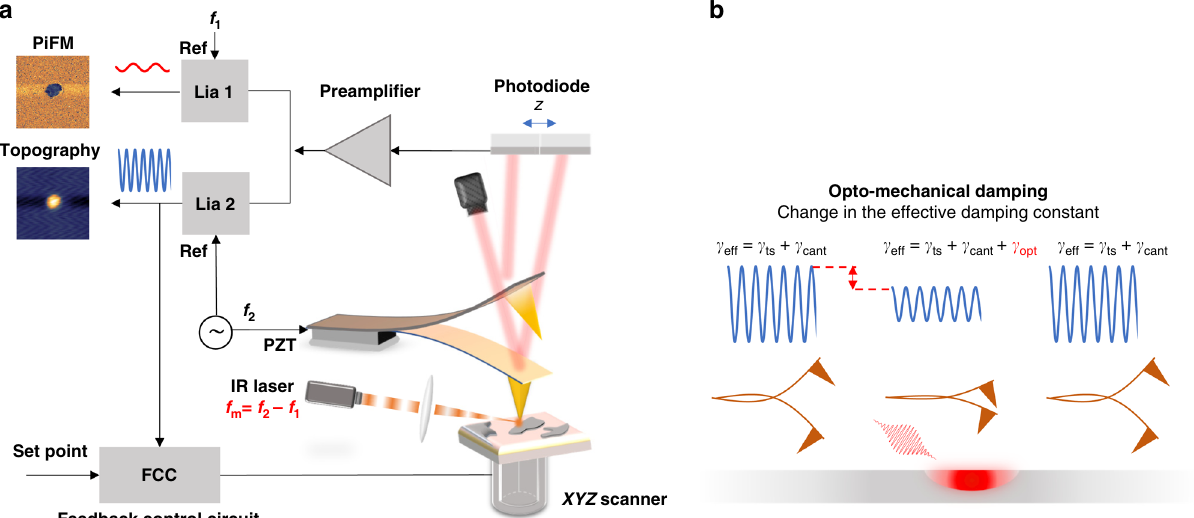
Fig. 1 Schematic of IR PiFM experiment and principle of opto-mechanical damping. a The cantilever is mechanically vibrated at its second mechanical eigenmode f 2 , so that peak – peak oscillation is 6 nm. Lock-in ampli fi er and feedback laser position sensitive detector (PSD) are used to stabilize the cantilever nanometers from sample surface. The IR source is electrically triggered at f m = f 2 − f 1 , where f 1 is the fi rst mechanical eigenmode of the cantilever. The incident infrared pulse is p-polarized (along the tip axis) and focused to 20- μ m-diameter spot. The topography and the PiFM signals are simultaneously recorded at f 2 and f 1 , respectively. The image is generated via raster-scanning the sample under the tip. b illustrates the principle of opto- mechanical damping, where oscillation amplitude is damped due to IR vibrational